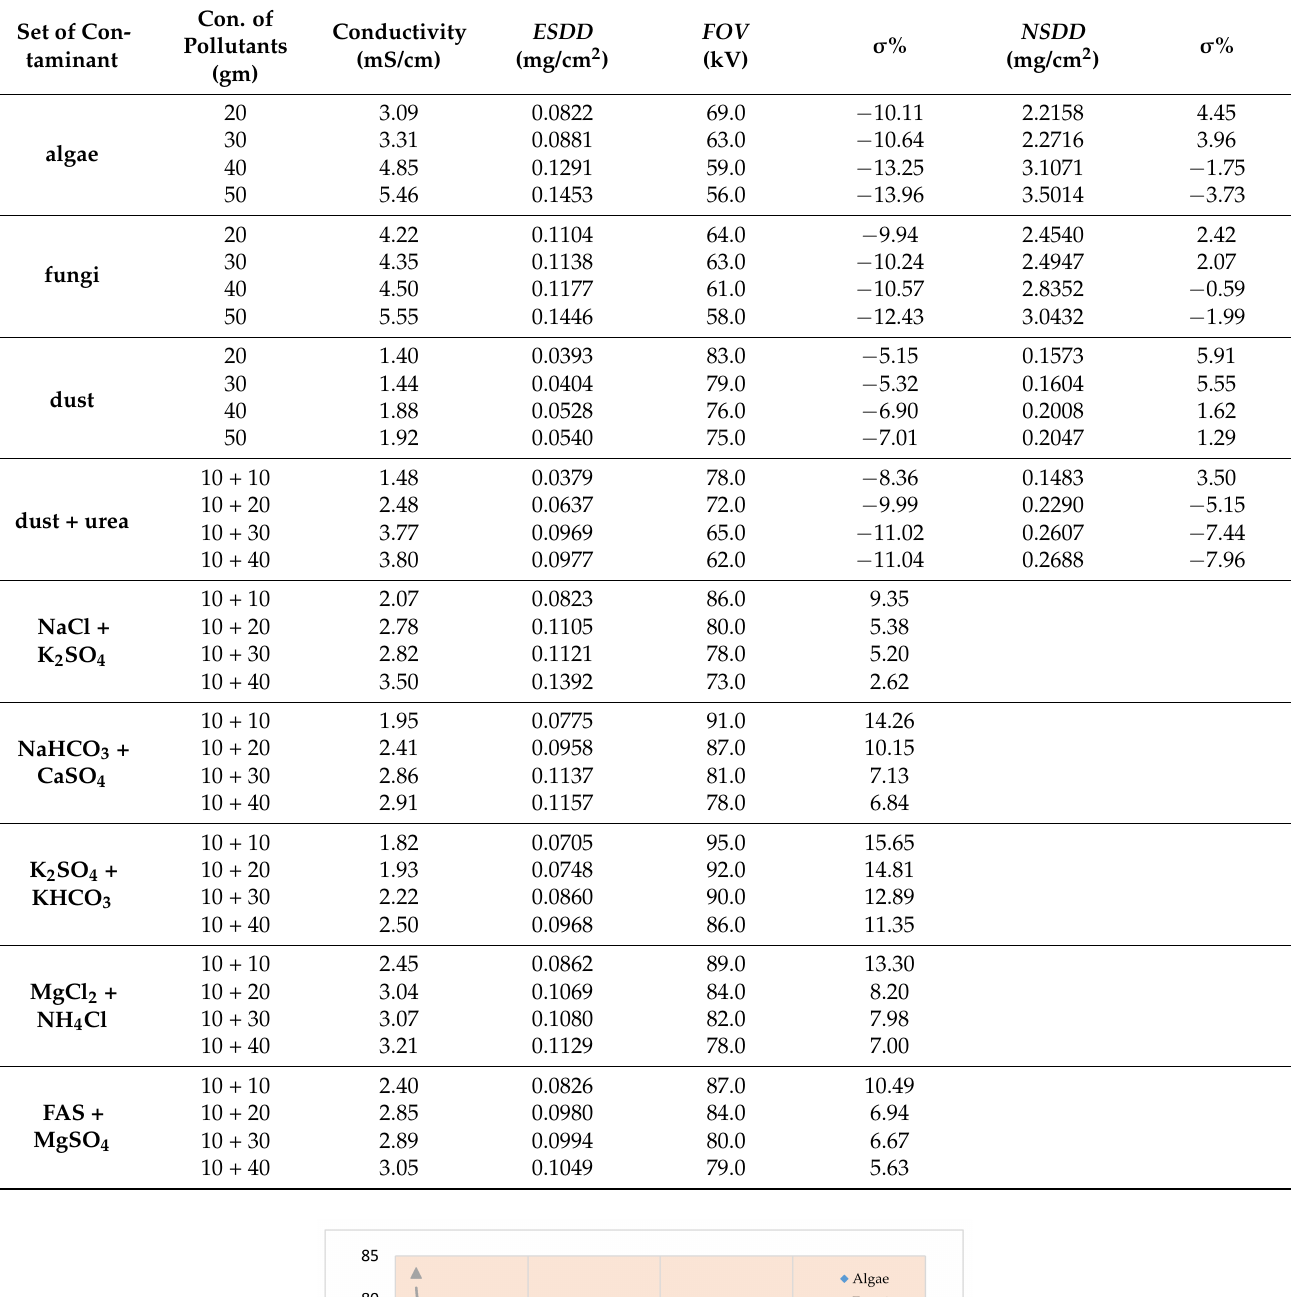
Table 1. Test results of flashover voltages under biological and agricultural contaminants.